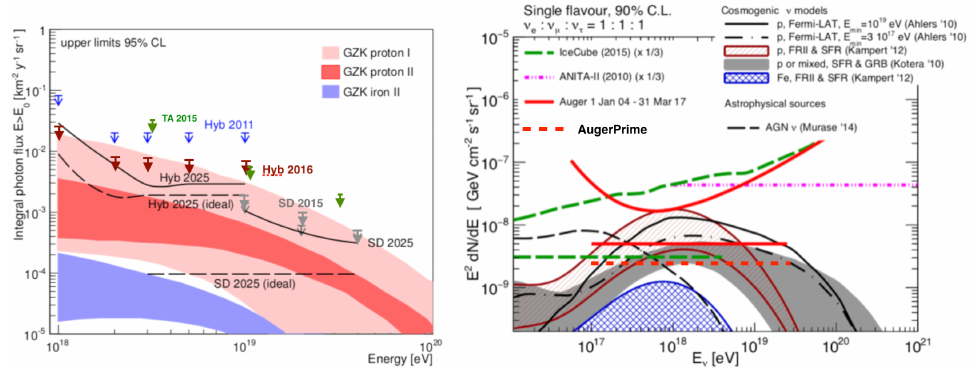
Figure 10. Expected sensitivity on the flux of photons (left) and neutrinos (right) [26, 27]. For photons, full black lines show more conservative estimates based only on the increase of